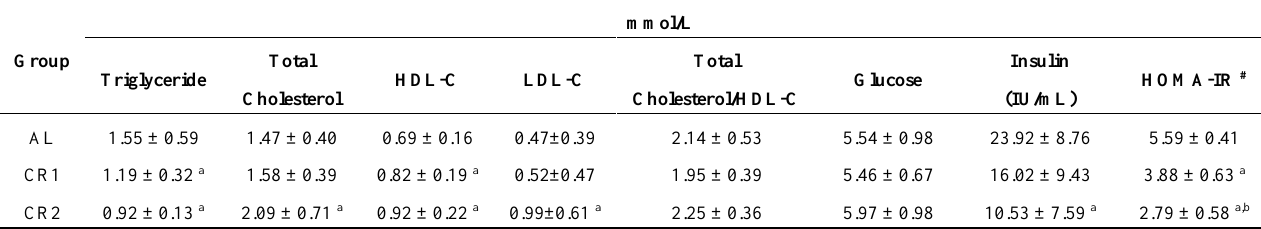
Table 2. Fasting blood lipid, metabolic and insulin responses in rats of different levels of calorie restriction † ,